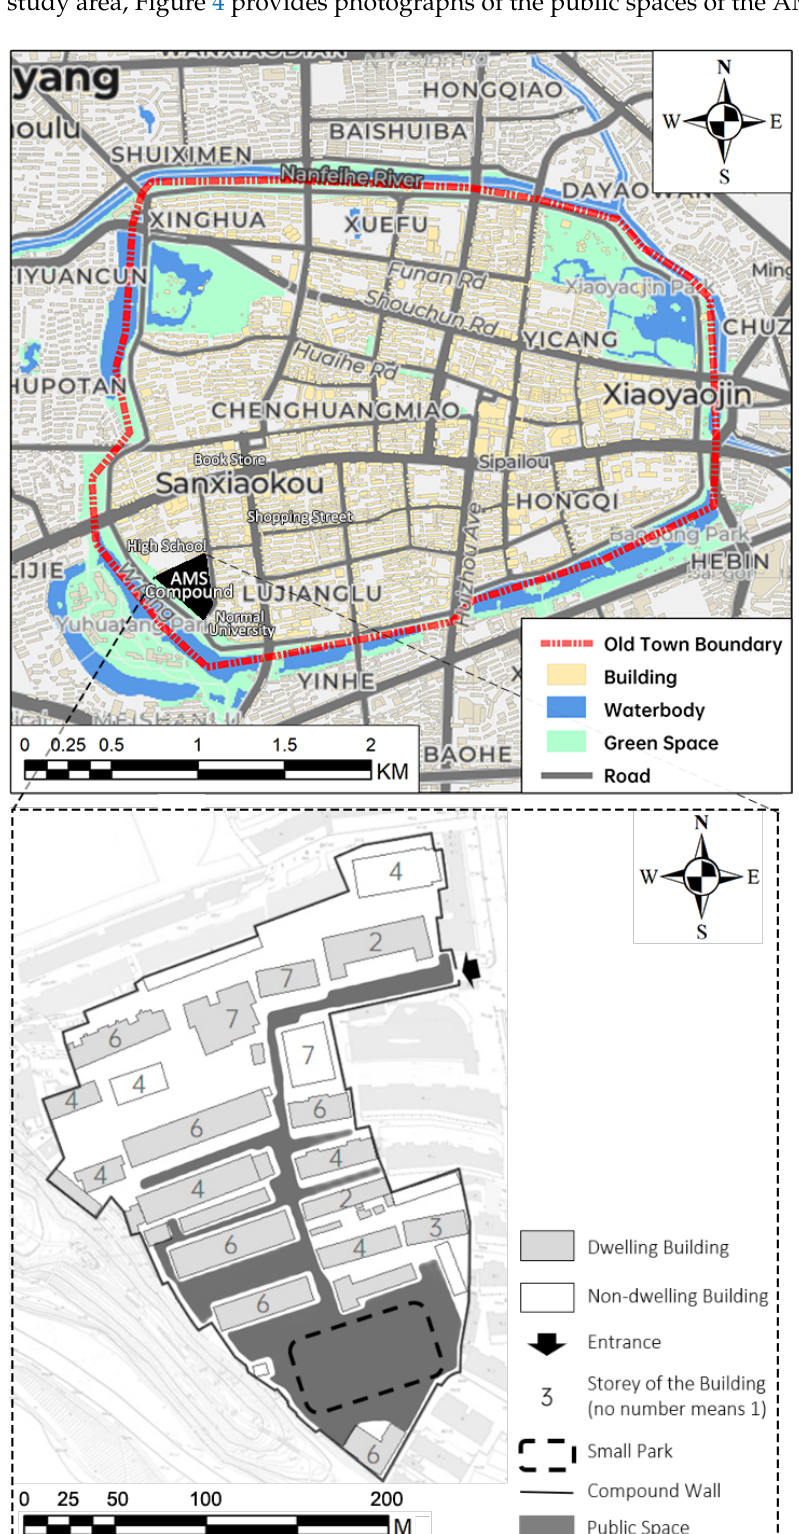
Figure 3. Map of Hefei Old Town and the AMS Danwei